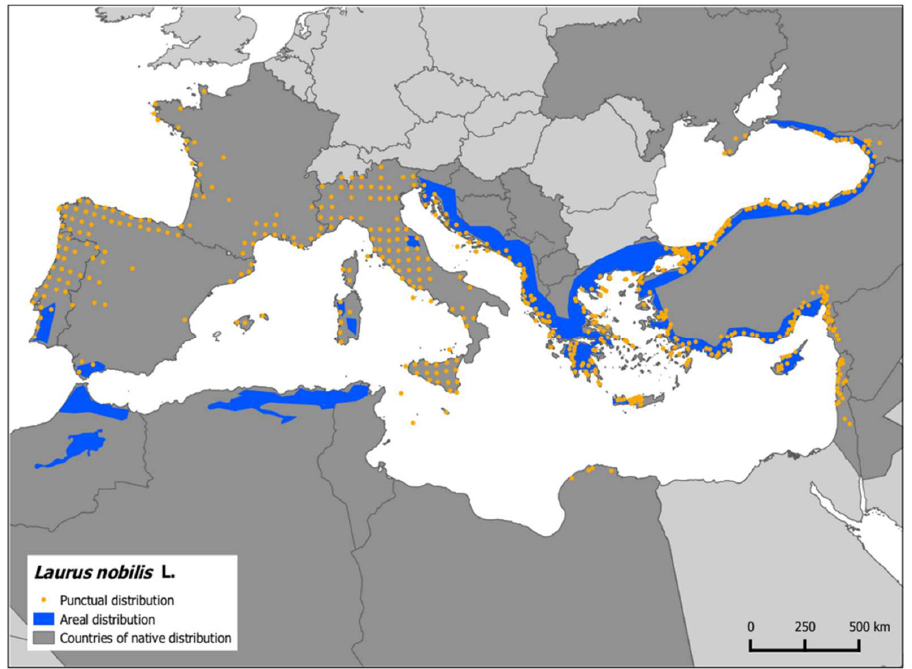
Figure 1. Distribution of L. nobilis L. Source-FAO.